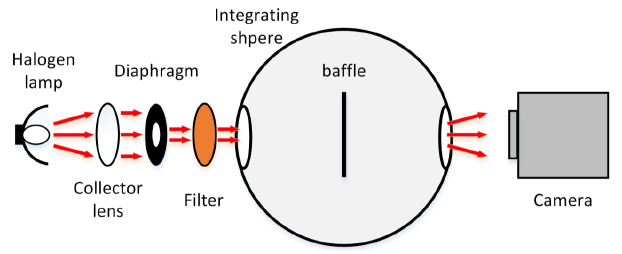
Fig. 2. A custom-build optical system for PTC measurement. The light from a halogen lamp (EJL 13164 24V200W Philips) is collected by a quartz lens with focal length of 30 mm (Spectral Analysis, China), ¯ltered by either a 20 nm bandpass ¯lter centered at 698 nm or a 40 nm bandpass ¯lter centered at 594 nm (both from Mega-9, China), then entered a 30 cm di- ameter commercial integrating sphere (Flight technology, China). The camera under investigation is placed 32 cm away from the exit port (8 cm diameter) of the integration sphere, and a heavy duty lab jack (L490/M, Thorlabs) is used to align the